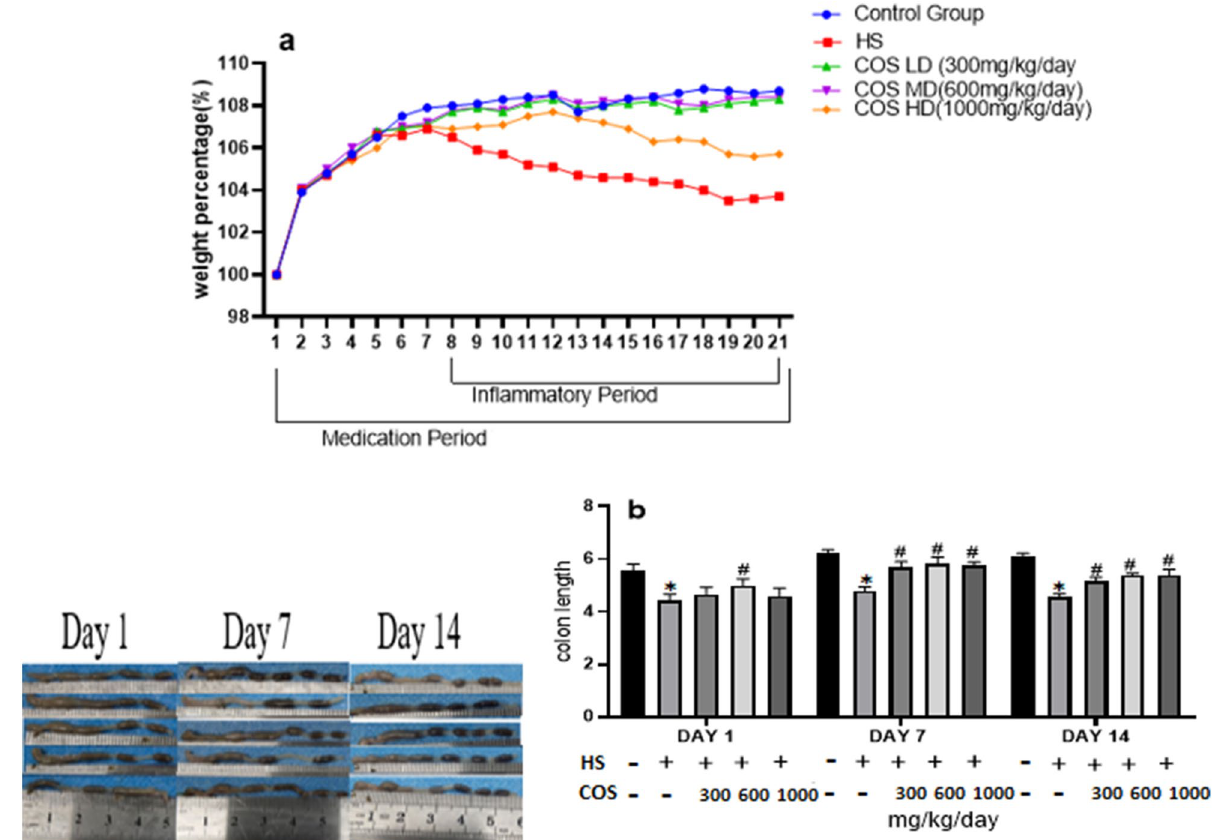
Figure 1. Effect of chitosan treatment on the mice. ( a ) Body weight ( b ) Colon length. Control: normal mice; HS: Heat stress mice; COS-LD: mice treated with HS plus COS (300 mg/kg); COS-MD: mice treated with HS plus COS (600 mg/kg); COS-HD: mice treated with HS plus COS (1000 mg/kg). Data are expressed as mean ± standard error. *Indicates p < 0.05 compared with the blank control group, and # indicates p < 0.05 compared with the HS control